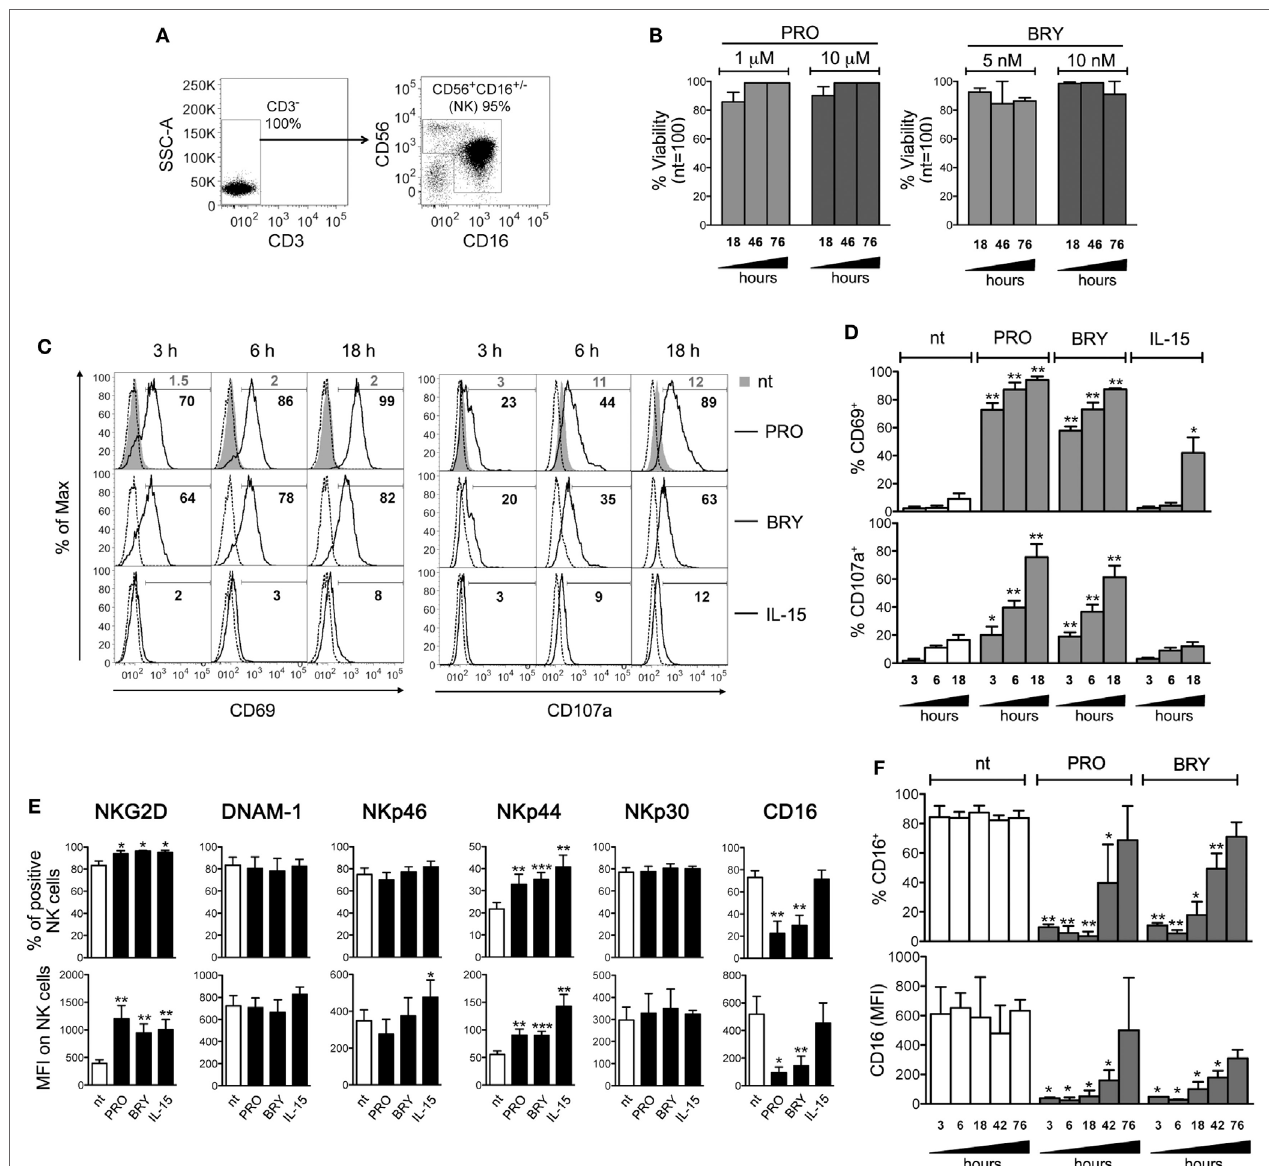
FigUre 1 | Prostratin (PRO) and bryostatin-1 (BRY) activate natural killer (NK) cells and modulate activating receptors. (a) The purity of NK cells isolated from PBMCs was examined by flow cytometry measuring the frequency of CD3 − CD56 + CD16 + / − cells. (B) NK cells were cultured for 18, 46, and 76 h in medium alone [not treated (nt)] or supplemented with 1 or 10 µM PRO, or with 5 or 10 nM BRY. The viability of gated NK cells was examined by LIVE/DEAD staining and expressed relatively to nt cells set at 100%. Bars represent mean ± SEM ( n = 3). (c–F) NK cells treated or not with 1 µM PRO, 10 nM BRY, or 12.5 ng/ml of IL-15 were examined at various time points as indicated (c,D,F) or after 18 h only (e) for the expression of various markers: (c,D) the frequency of CD69 + and CD107a + NK cells among nt (filled gray histograms, gray percentages) and treated cells (open histograms, black percentages) is shown together with control IgG signal (dashed line) for a representative experiment (c) and as mean ± SEM (D) ; (e,F) mean ± SEM of both percentage of positive cells and mean fluorescence intensity (MFI) for NKG2D, DNAM-1, NKp46, NKp44, NKp30, and CD16 is shown. Experiments were performed with at least three independent donors [up to eight in panel (e) ]. * P < 0.05, ** P < 0.01, and *** P < 0.001 by paired t